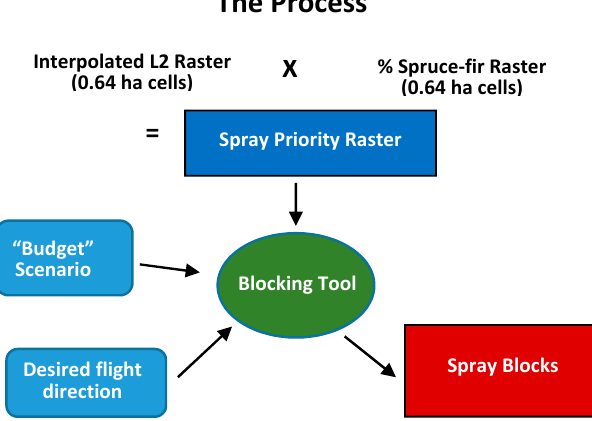
Figure 2. The EIS SBW treatment priority and blocking tool process.